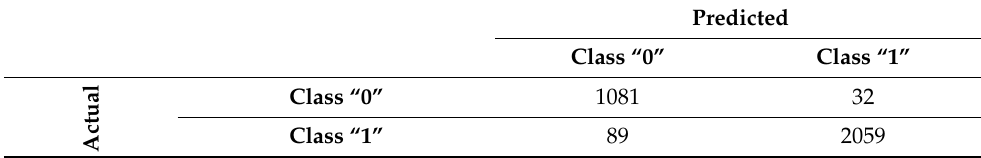
Table 9. Confusion matrix for J48 DT.